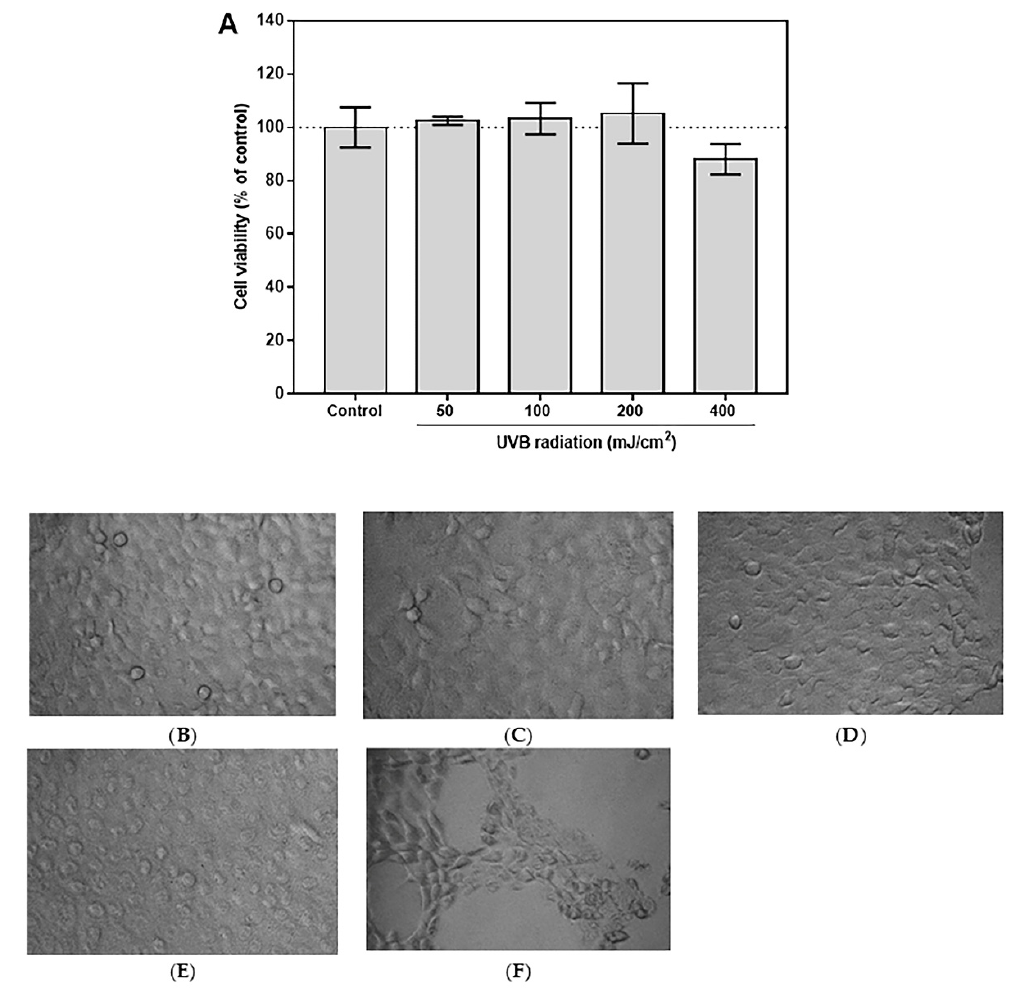
Figure 5. Effect of UVB irradiation on HaCaT viability. Cells were irradiated with various UVB intensities. They were then incubated in a culture medium for 24 h. ( A ) Cytotoxicity was conducted by MTS assay of non-UVB-irradiated and UVB-irradiated cells (100% of control). Data are presented as means ± S.D. Morphologies of ( B ) non-UVB-irradiated cells or cells irradiated with UVB at a dose of ( C ) 50 mJ/cm 2 , ( D ) 100 mJ/cm 2 , ( E ) 200 mJ/cm 2 , and ( F ) 400 mJ/cm 2 .